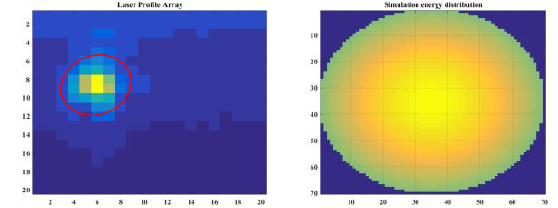
Figure 7. LPA energy distribution and simulated energy distribution